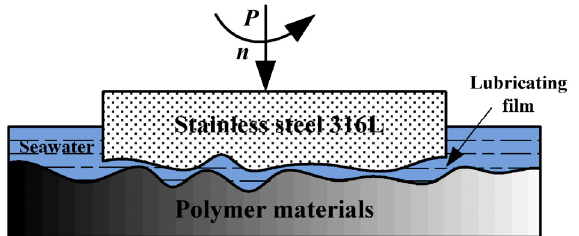
Fig. 7 Model of the beneficial effect of seawater.